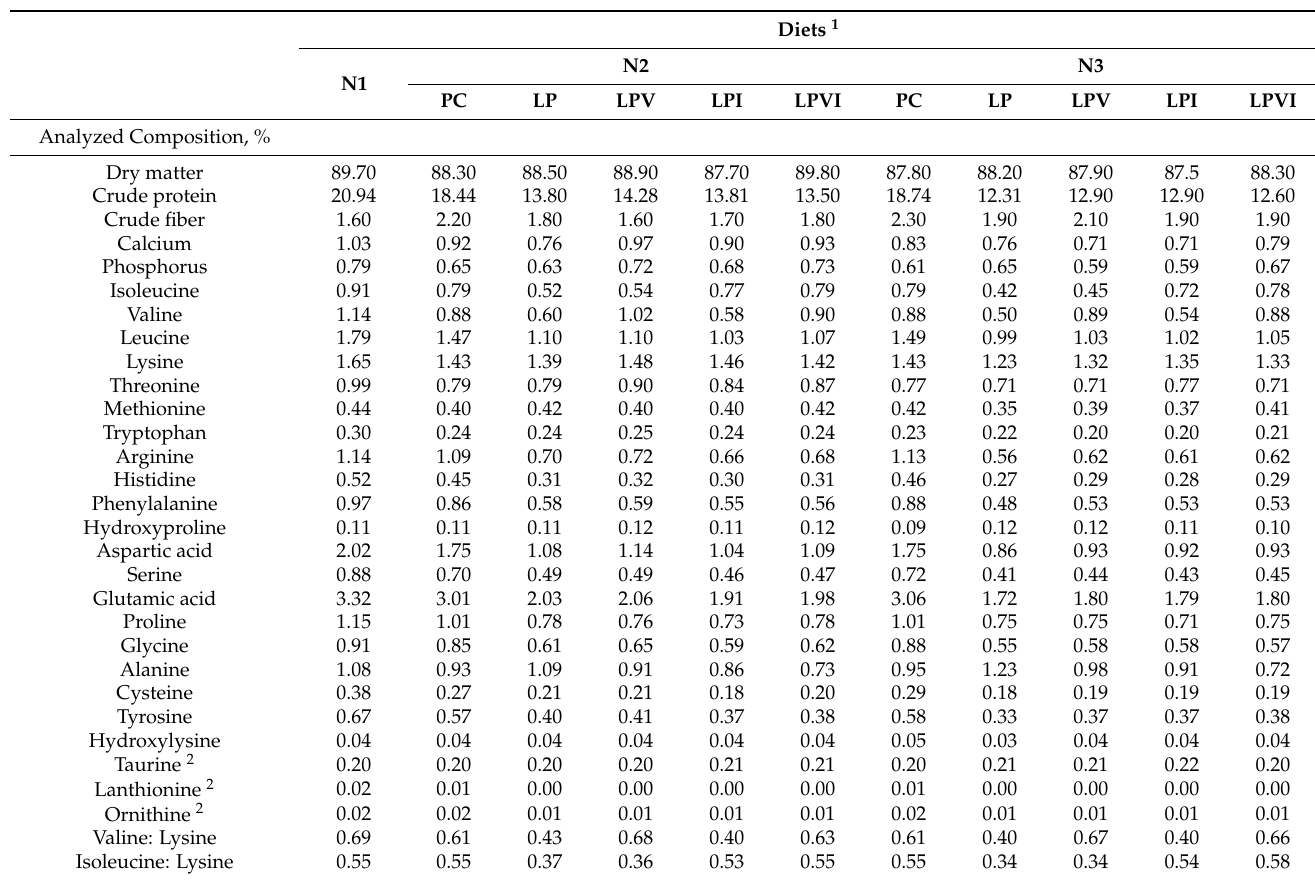
Table 5. Analyzed chemical composition and amino acid content of experimental diets (as-fed